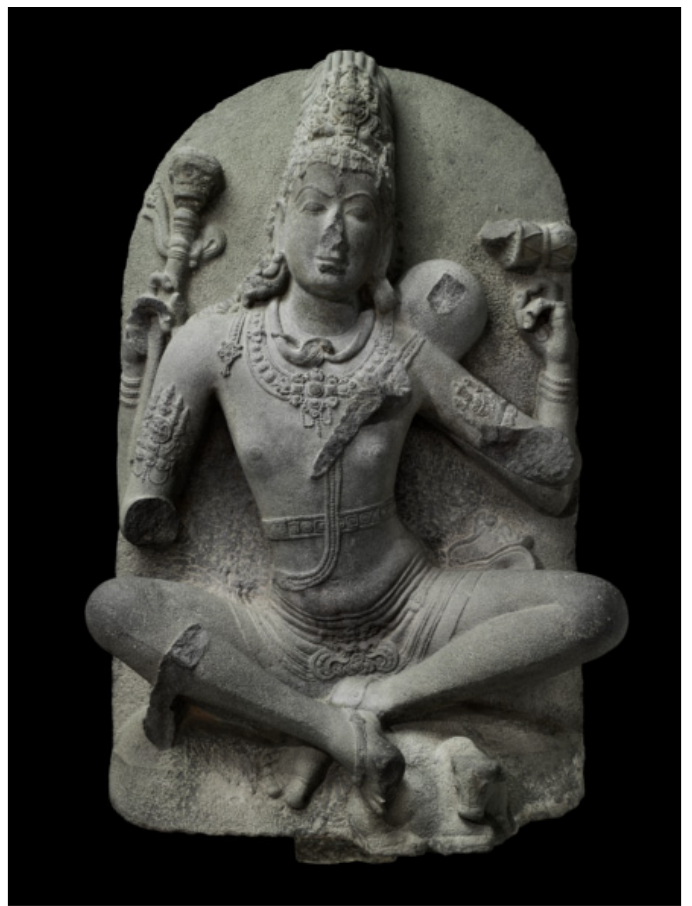
Figure 6. Shiva as Lord of Music (Shiva Vinadhara), Tamil Nadu, late 9th–mid-10th century. 48 1/16 × 31 1/2 × 14 in. (122 × 80 × 35.6 cm). Museum of Fine Arts, Boston, Maria Antoinette Evans Fund, 33.18. Photograph © Museum of Fine Arts, Boston.